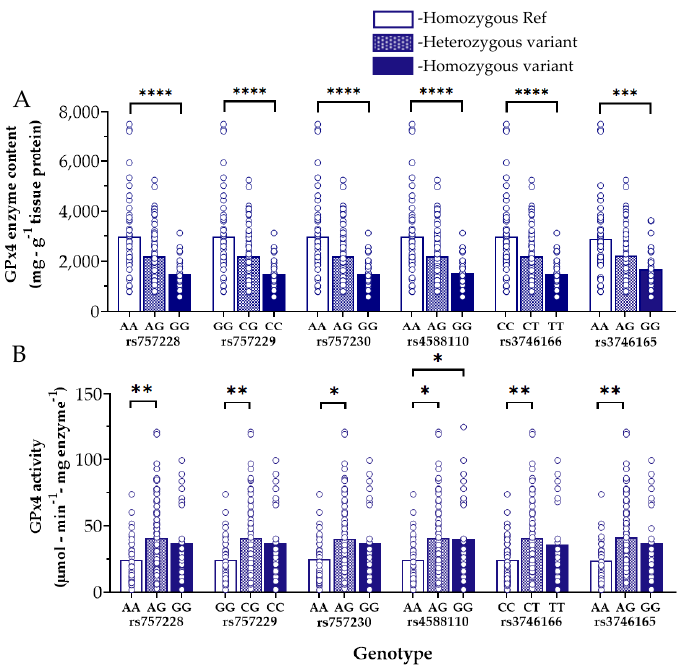
Figure 3. GPX4 variants associated with decreased GPx4 enzyme content but increased activity in human atrial myocardium. Five distinct polymorphisms associated with decreased tissue levels of GPx4 enzyme ( A ) but increased GPx4 activity ( B ) are shown in the panels above. Each open circle represents one patient, open bars = Homozygous for the Referent nucleotide, hatched bars = Heterozygous for the variant nucleotide (i.e., one allele), filled bars = Homozygous for the variant nucleotide. **** p < 0.0001, *** p < 0.001, ** p < 0.01, * p < 0.05 for main effect between genotypes indicated.